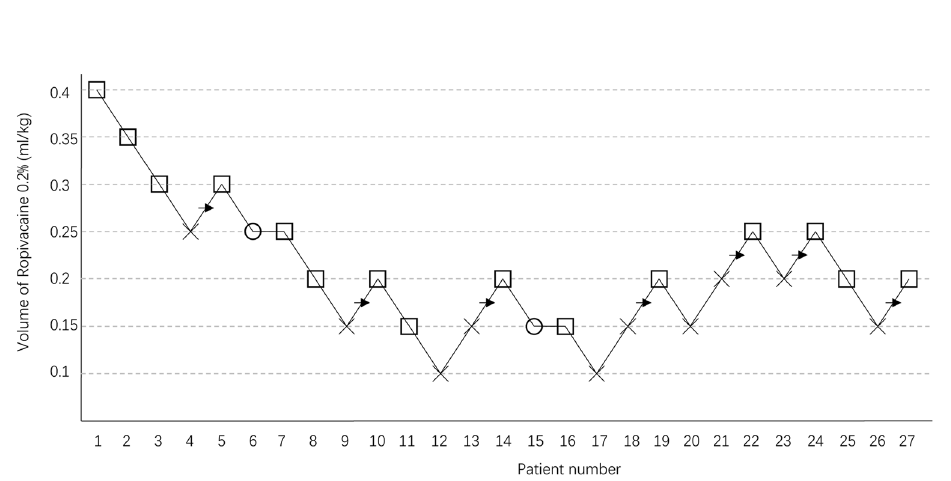
Figure 3. The up-and-down sequence of volumes of 0.2% ropivacaine required to produce an effective block. × failed block, □ effective block, ○ loss of sensory block score, → midpoint of “failed-effective”